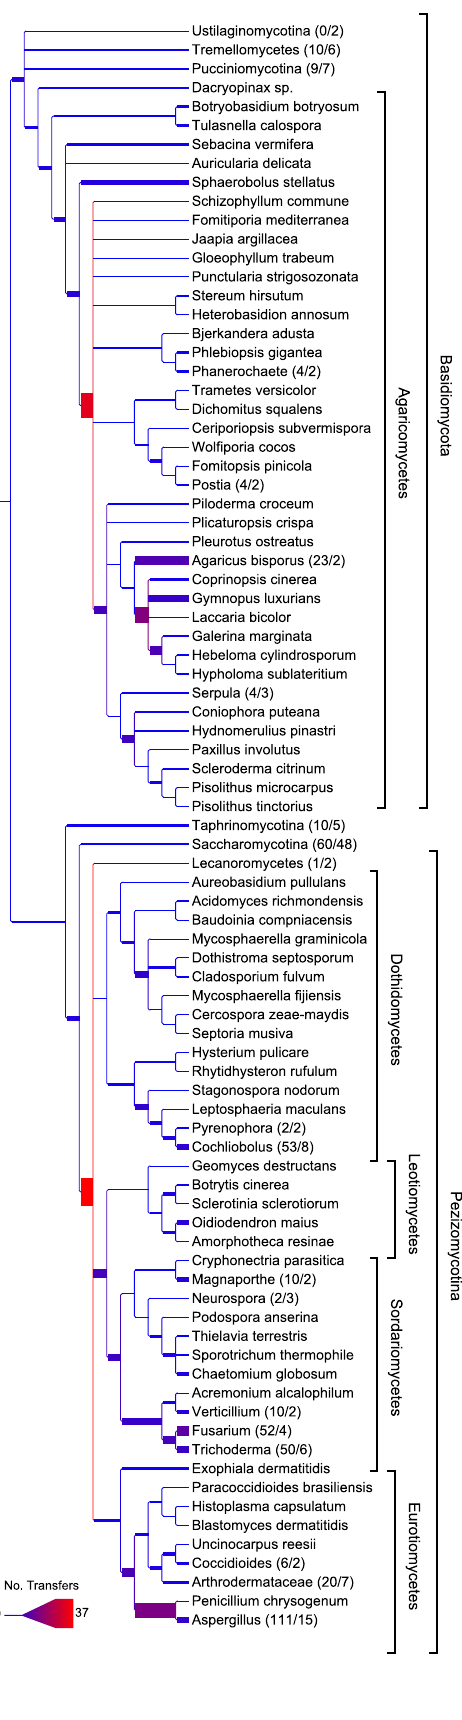
Figure 3. The episodic occurrence of HGT across the fungal species phylogeny. Numbers in parentheses indicate the number of HGT events and the number of genomes downstream of the collapsed nodes, respectively. Some clades have been collapsed for clarity; see Figure S2 for a depiction of the entire species phylogeny. The thickness and color of each branch corresponds to number of ECgenes transferred to each branch, adjusted by the number of genomes in the case of collapsed